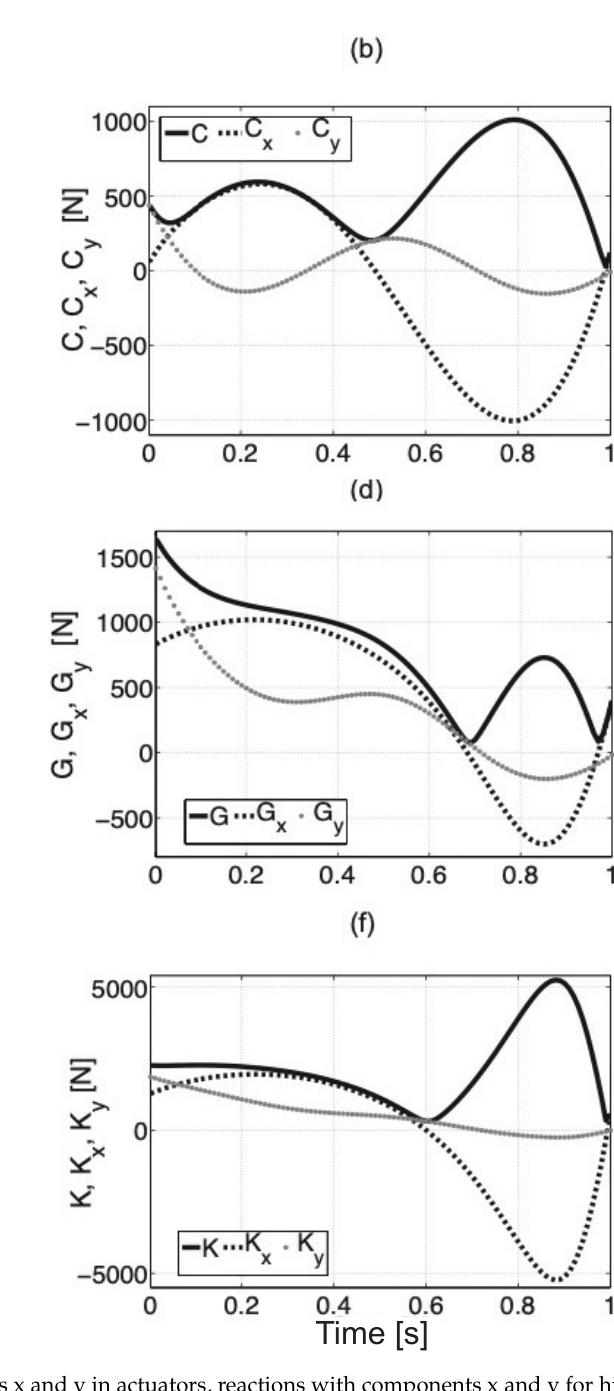
Figure 8. Force values F 1 ( a ), F 2 ( c ), F 3 ( e ) with components x and y in actuators, reactions with components x and y for hip ( b ), knee ( d ), and ankle ( f )